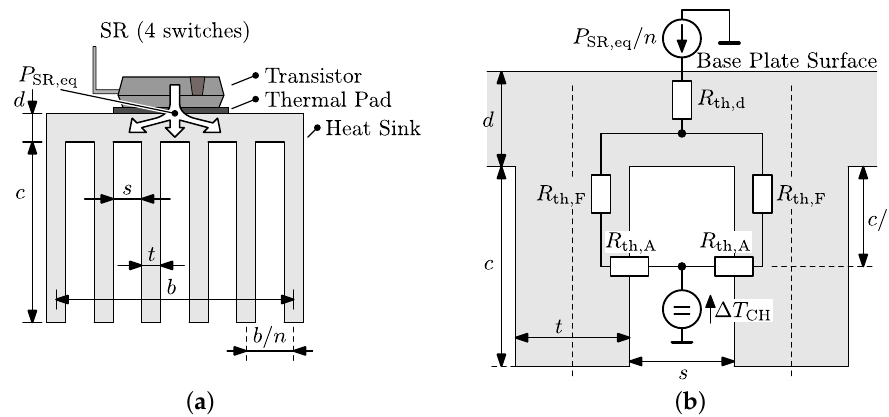
Figure 11. ( a ) Heat sink geometry with single-sided base plate, considered to cool the switches of the SR; ( b ) Thermal network describing stationary heat transfer between the surface of the base plate and the air in the heat sink channel (temperature T CH